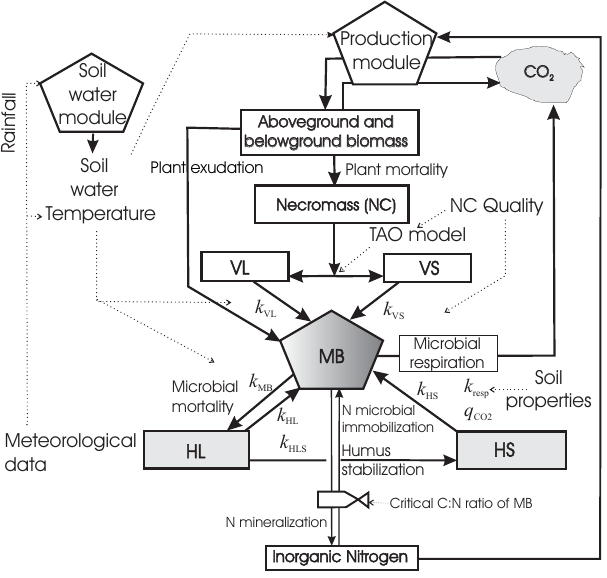
Fig. 1. Flow diagram for the MOMOS model coupled with a soil water module and a production module; MB is the microbial biomass, VL is the labile necromass (NC), VS is the stable necro- mass (NC); HL is the labile humus, HS is the stable humus; see table 3 for meaning of the k